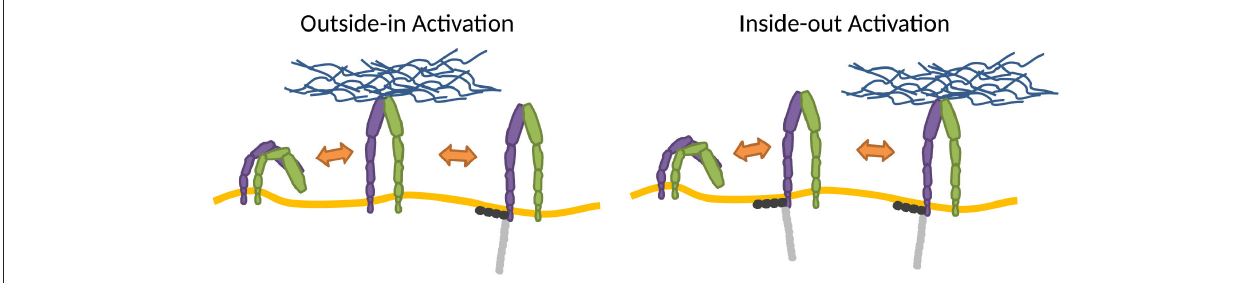
FIGURE 2 | Mechanisms of integrin activation. In the outside-in activation, extracellular factors activate the integrin (Barczyk et al., 2010; Park and Goda, 2016), subsequently stabilized by binding adaptor proteins to the cytoplasmic tail. In the inside-out activation, binding of cytoplasmic factors induces activation (Ye et al., 2010; Calderwood et al., 2013), which primes the integrin for ECM binding. Integrins also stochastically switch between